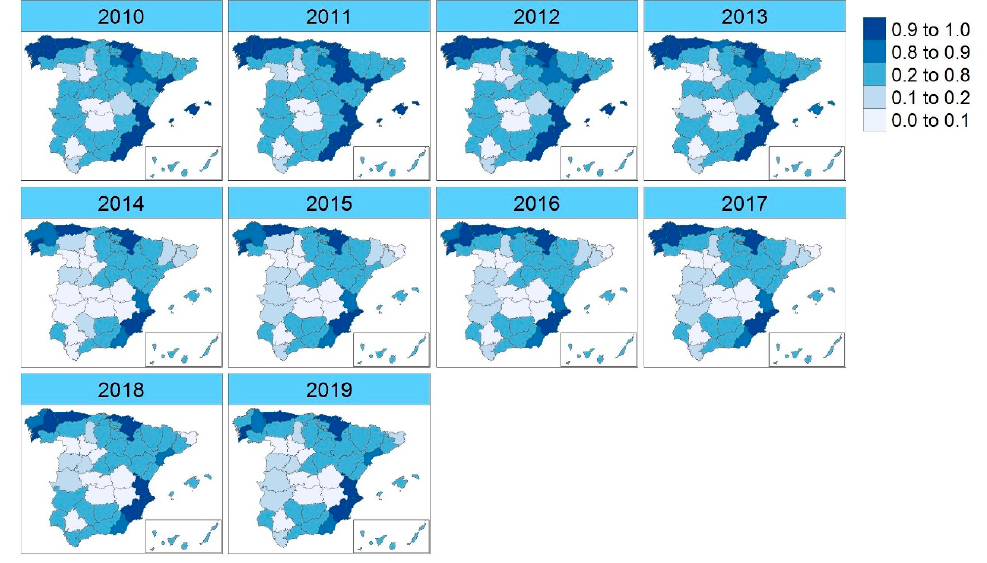
Figure 4. Maps showing the posterior exceedance probabilities of tractor fatality rates being higher than the overall rate for Spain, per province and year.